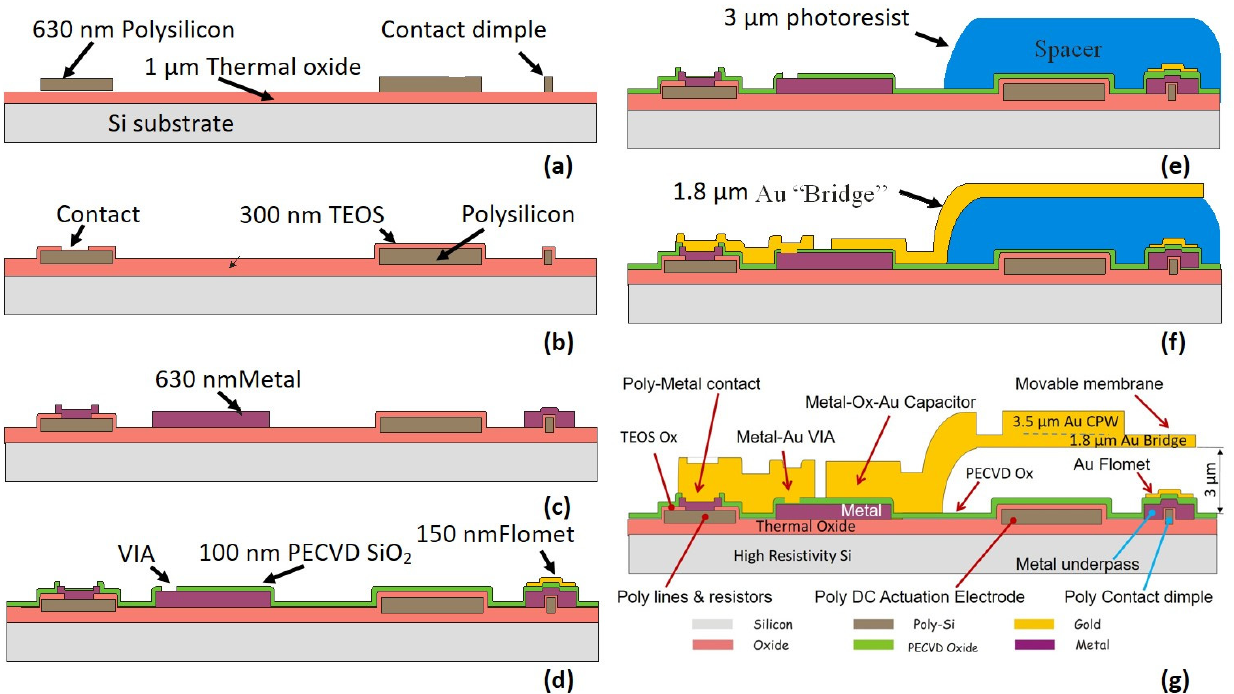
Figure 4. RF-MEMS switch fabrication-process flow Adapted with permission from Ref. [28]. Figure 4. RF ‐ MEMS switch fabrication ‐ process flow A dapted with permission from Ref. [28]. 2022, 2022, Elsevier